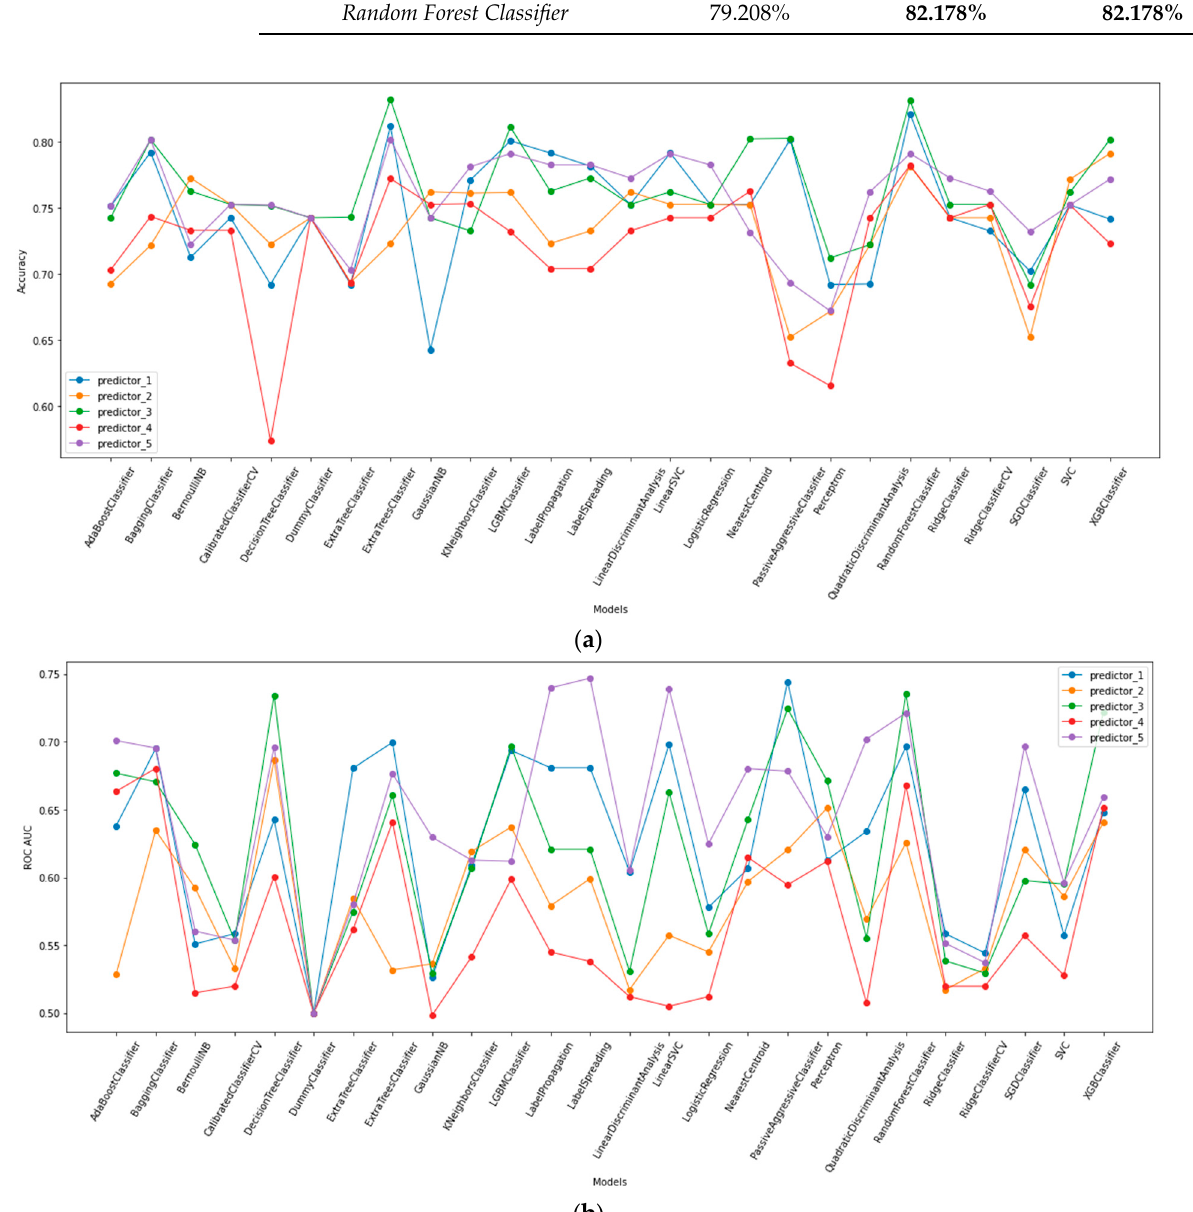
Figure 2. Summary of Lazy Predict library results of 36 ML models for five established predictors. ( a ) Accuracy score, ( b ) ROC AUC score. Two models were removed due to poor fit. Predictor_1: BATF2, LY6E, MT2A and ISG15. Predictor_2: BATF2, SERPING1, MT2A, and FBXO 6. Predictor_3: BATF2 , ISG15 , SERPING1 , LY6E, and EFHC2.